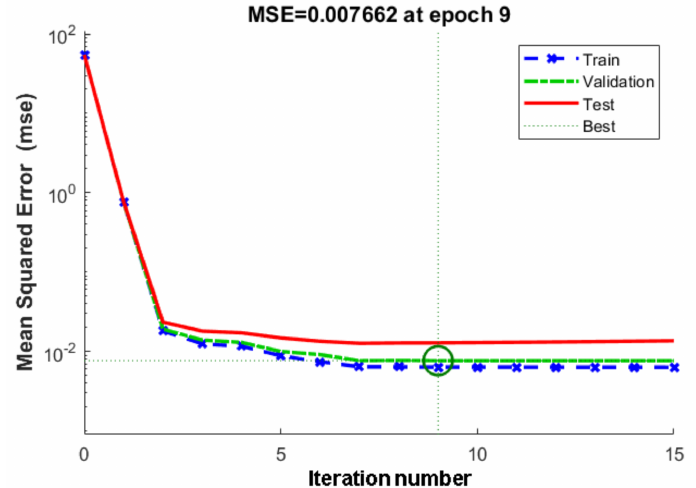
Figure 8. Optimized neural network training performance.